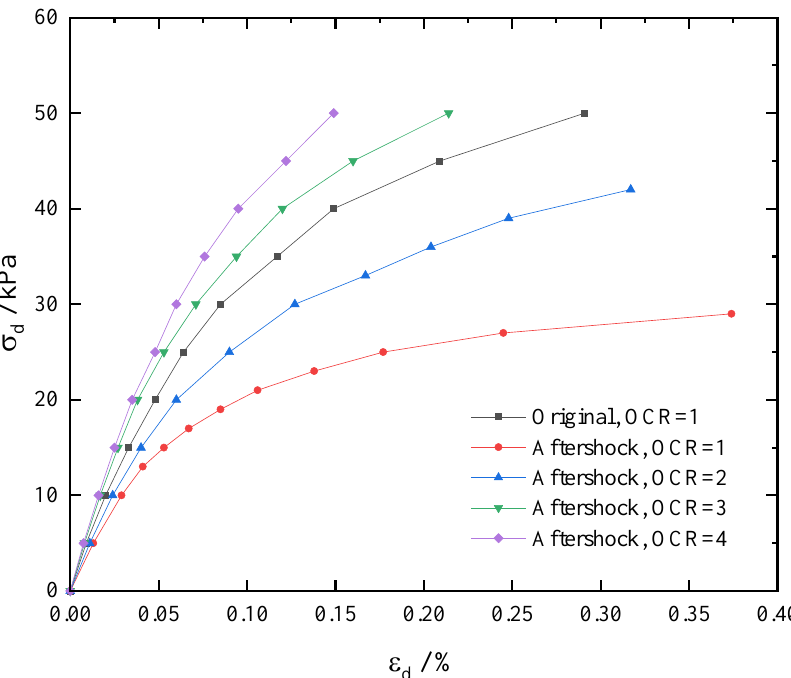
Figure 7. Dynamic stress: dynamic strain curves of the saturated loess before and after pre-shock and reconsolidation.